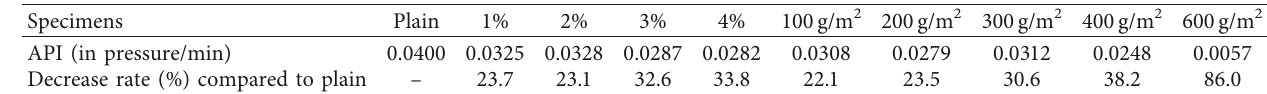
Figure 14: Carbonation depth of C-SSR after 7, 14, and 28days of accelerated Table 4: API of specimens with ISR and SSR.